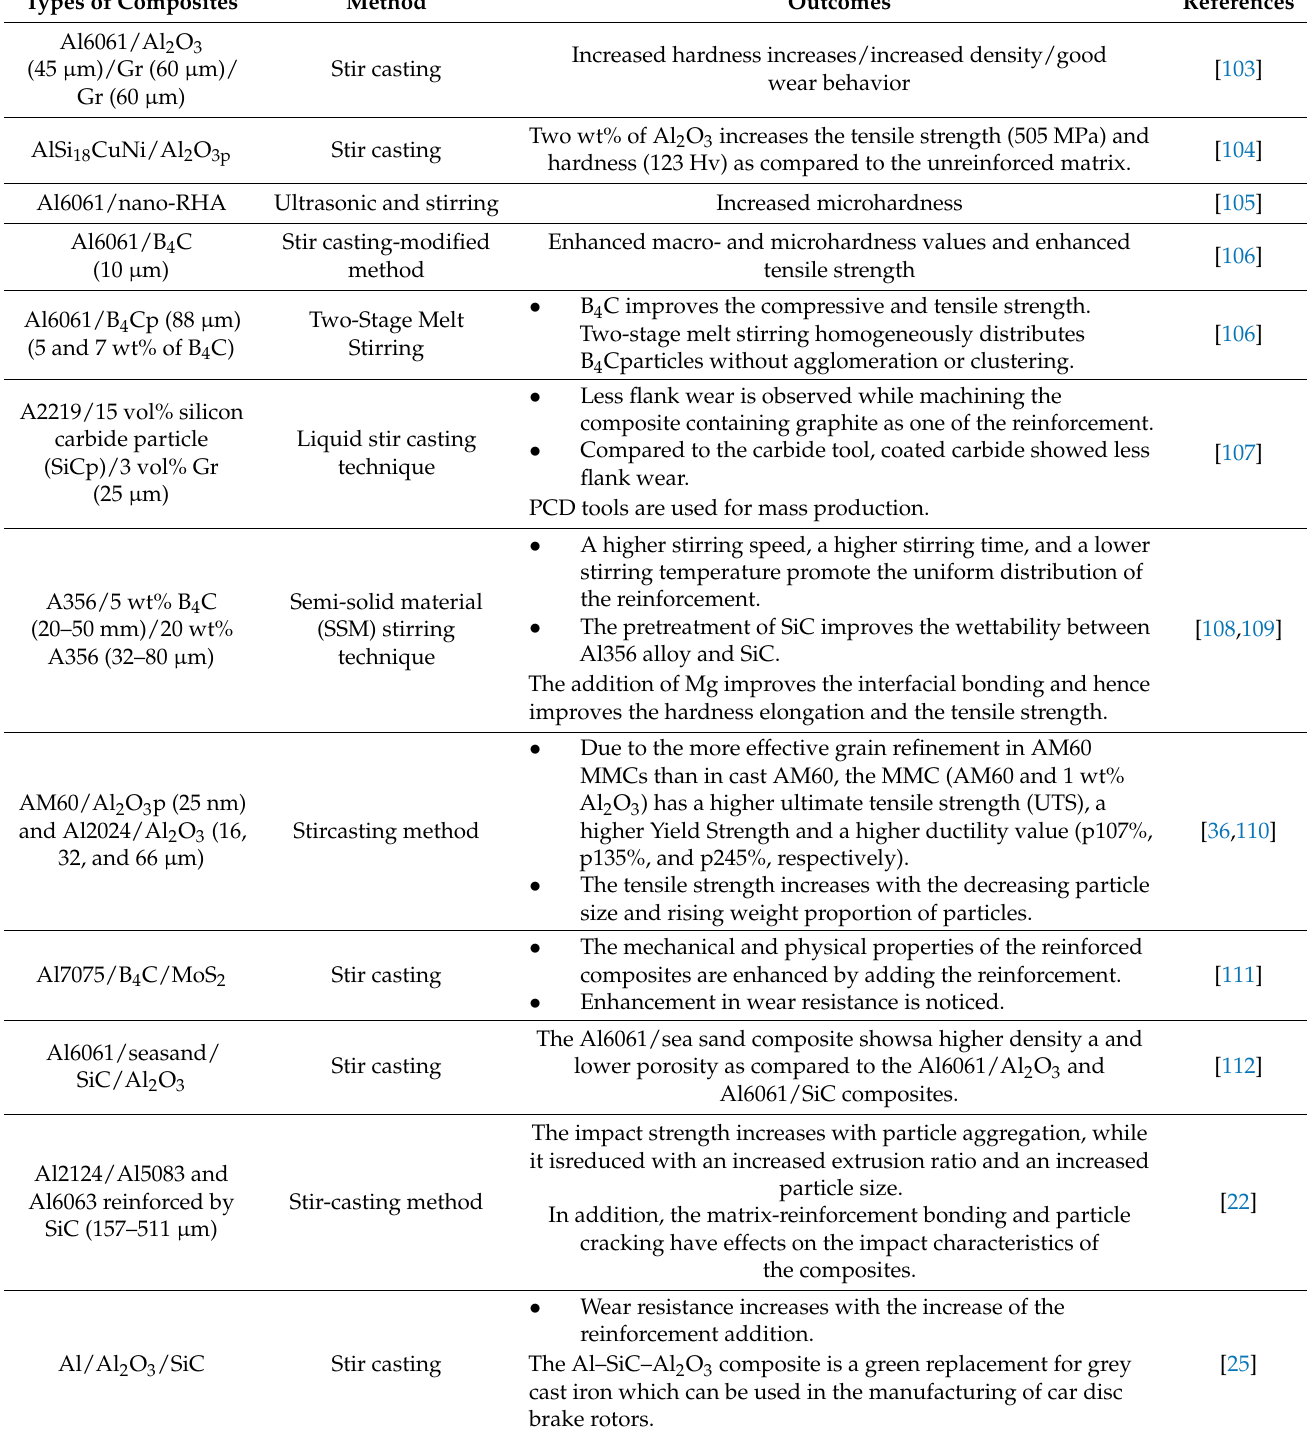
Table 2. AMMCs fabrication with different reinforcements through stir processing